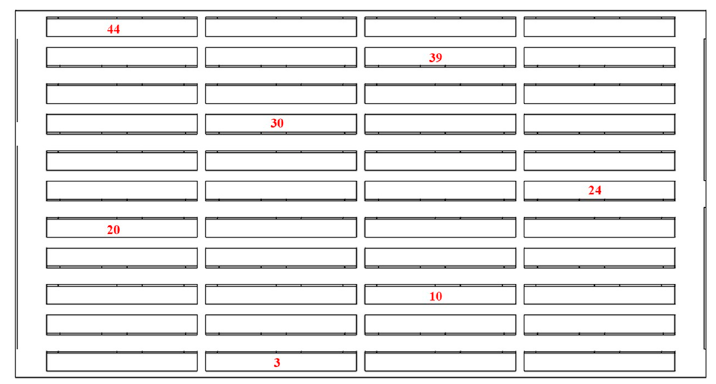
Figure 11. Temperature monitoring layout of the battery pack.